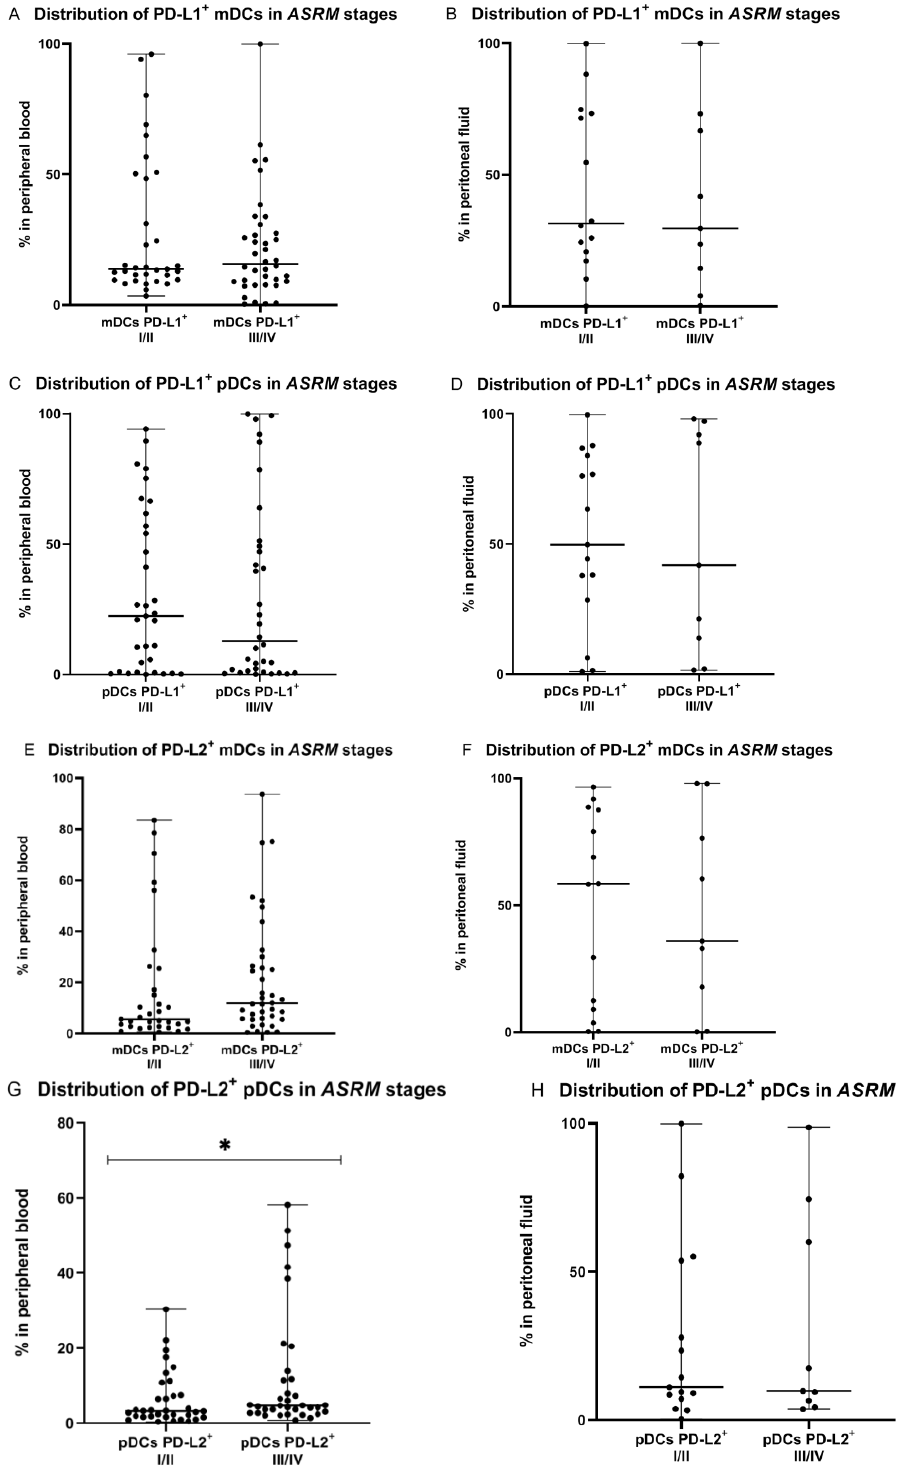
Figure 6. Percentage of mDCs and pDCs with PD-L1 and PD-L2 expression in peripheral blood and peritoneal fluid in early (I/II) and late (III/IV) ASRM stages of endometriosis ( A – H ). The median values with the following sign indicate statistically significant differences: * p < 0.05.